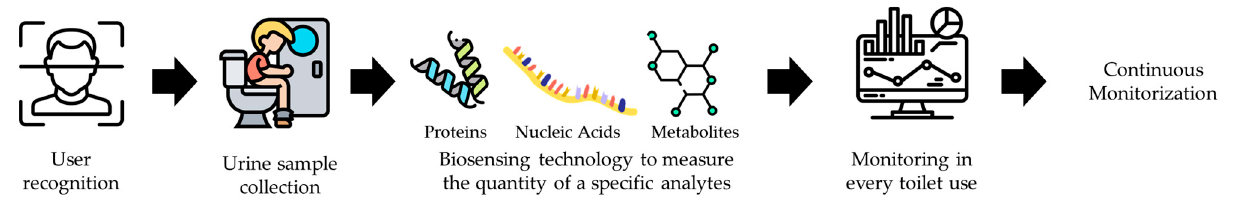
Figure 2. Schematic to demonstrate the process of continuous monitoring using a toilet to collect the sample.